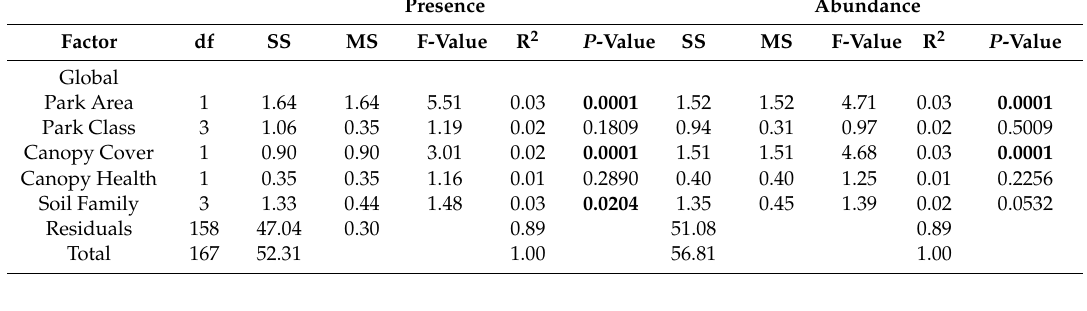
Table 3. PERMANOVA analysis showing correlation between five variables and the Phytophthora community based both on presence / absence data and number of reads. Bold P values indicate a significant relationship. Low R 2 values indicate that while significant these variables had little effect on the Phytophthora community.